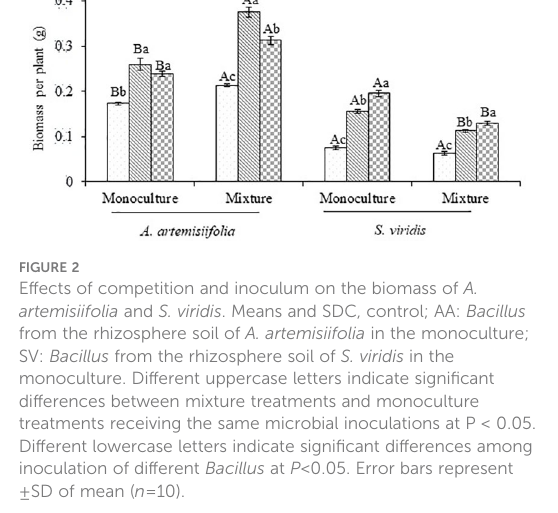
(Figure 4; Table S2). As for the inoculation of B. megaterium from A. artemisiifolia or S. viridis , the biomass in both plant species increased in parallel with the density of B. megaterium ( P <0.05), showing a dose-dependent relationship. Our analysis showed that the biomass of A. artemisiifolia in the C2 and C3 inoculation treatments increased signi fi cantly by 133.94%- 163.20% compared with the uninoculated treatment of the monoculture (all, P <0.001). Compared with the monoculture, competition had different effects on the biomass of A.